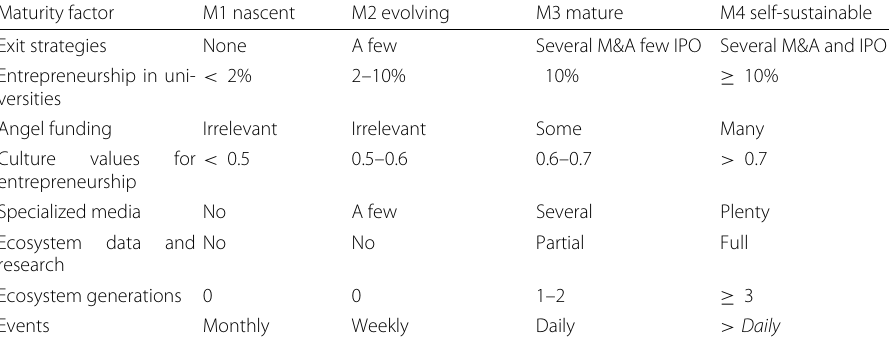
Table 3 Ecosystem maturity model: summarized